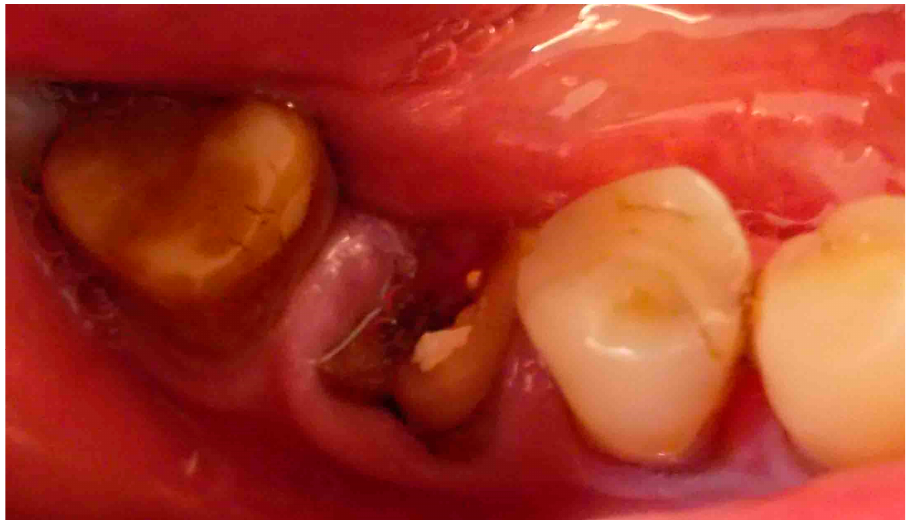
Figure 2. Roots of a decayed mandibular first molar (46) that received indication of extraction and alveolar ridge preservation.